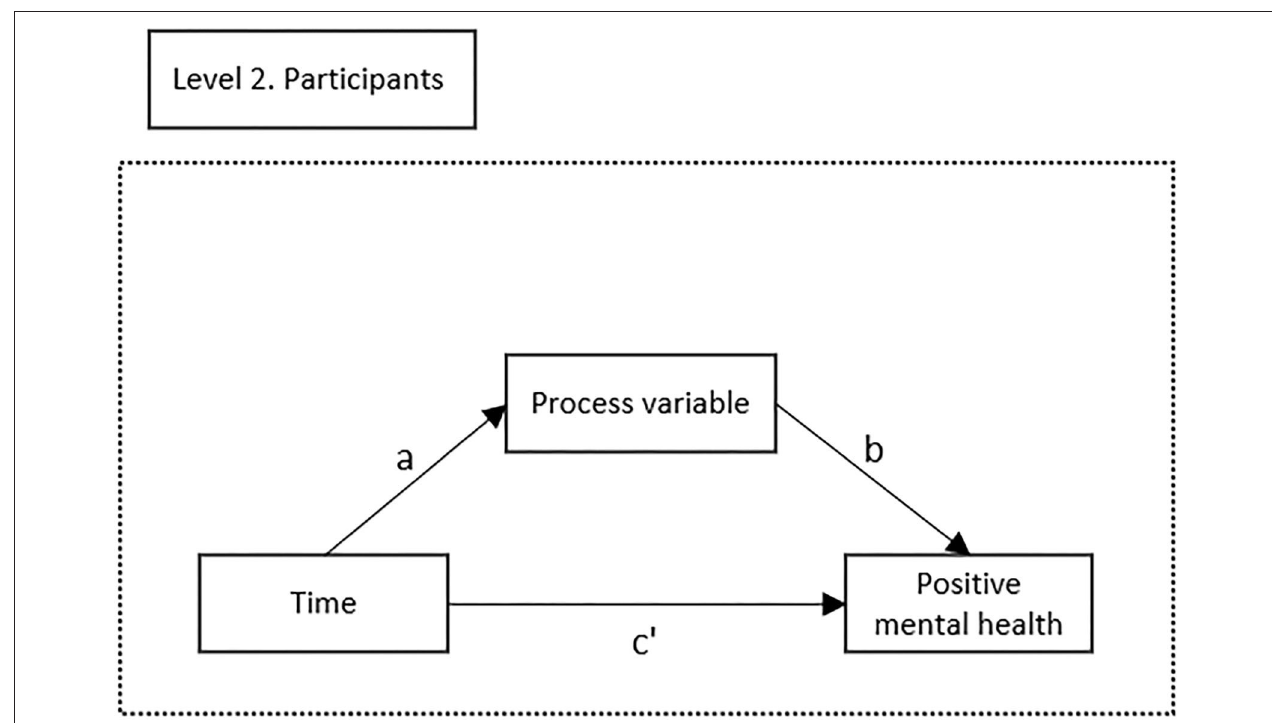
FIGURE 1 | Illustration of the multilevel mediation model. Path a represents the effect of time on the process variable. Path b represents the change in the process variable when positive mental health changes with one unit when time is held constant. Path c ′ represents the direct effect of time on positive mental health when controlling for the effect of changes in the process variable. Path a * b represents the within-group indirect effect of time on positive mental health represented by changes in the process